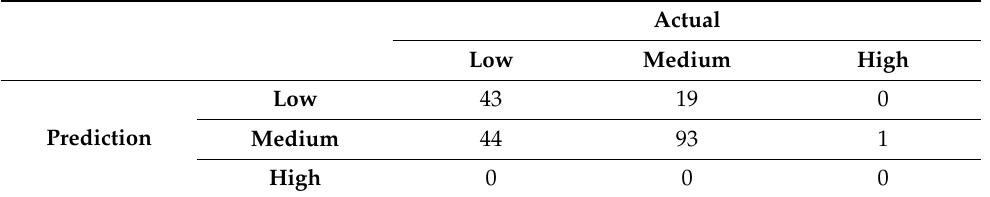
Table 10. Confusion matrix of the GLM technique after applying the GA.